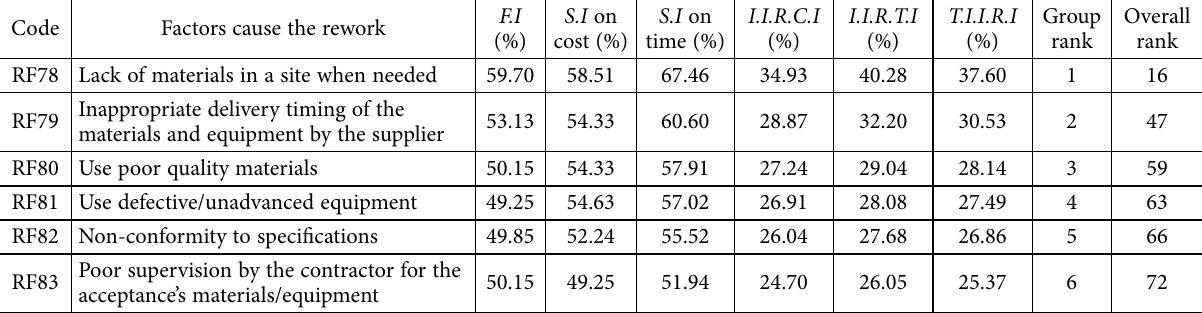
Table 12. Ranking the causes and impact of rework factors related to the materials and equipment Code Factors cause the